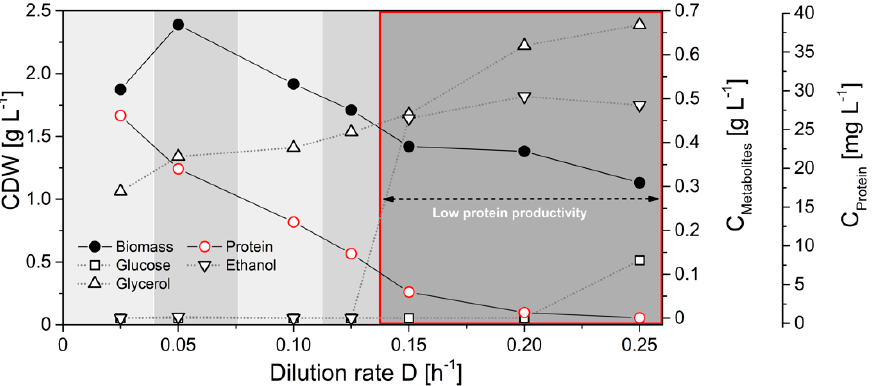
Figure 7. Cultivation profile of H. polymorpha RB11 conphys in aerobic continuous glucose-limited chemostats at different dilution rates with 0.5% ( w / v ) 100% (mol/mol) 1- 13 C glucose as the sole carbon source.